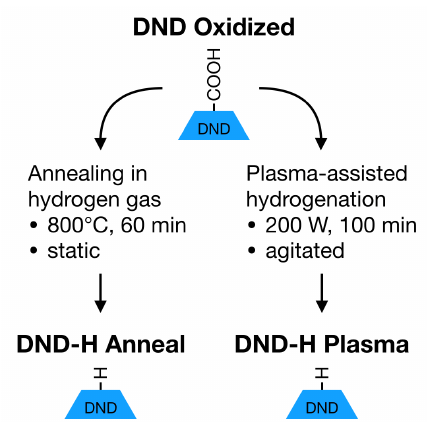
Figure 1. Schematic illustration of the two processes used for the hydrogenation of air oxidized detonation nanodiamonds (DND Oxidized) and the resulting particles (bottom). DND Oxidized particles were hydrogenated via annealing in pure hydrogen gas (DND-H Anneal) [8] and using a microwave plasma-assisted technique (DND-H Plasma)